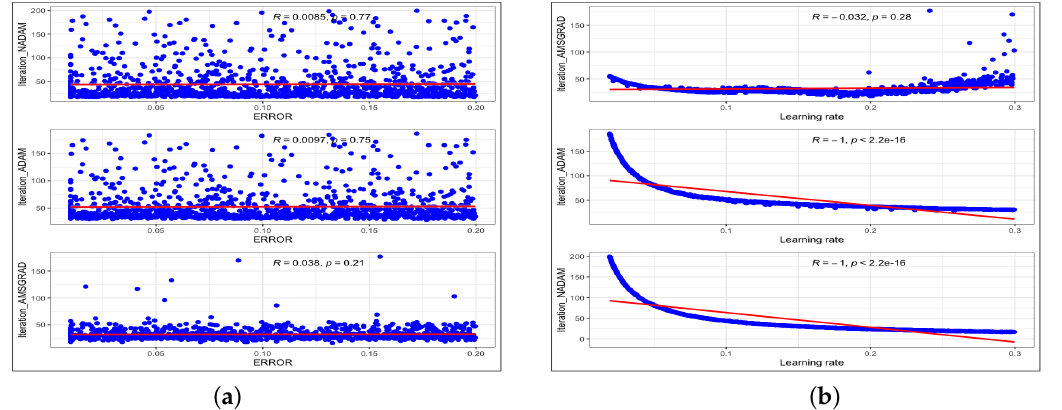
Figure 6. Correlation between number of iteration of each optimizer and ( a ) initial guess error δ ( b ) learning rate hyper parameter β